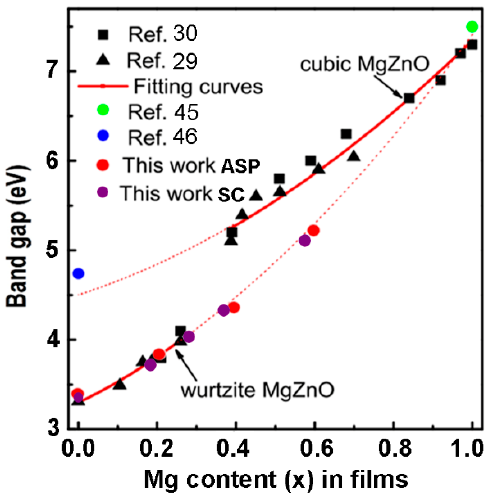
Figure 10. Dependence of the band gap of Zn 1-x Mg x O films on the Mg content x in films deposited by spin coating (SC) and by aerosol spray pyrolysis (ASP).